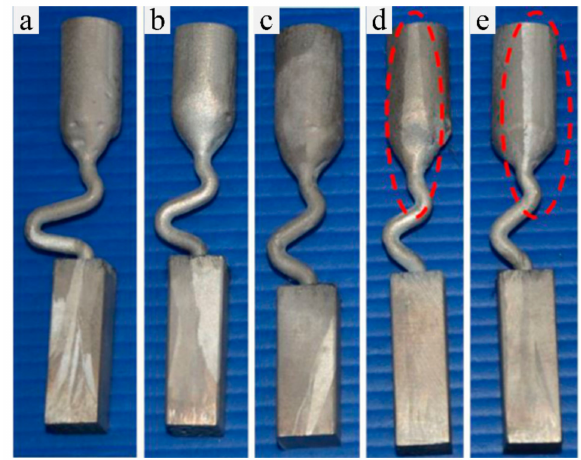
Figure 2. Z-form 2D grain selector with di ff erent take-o ff angle: ( a ) θ = 15 ◦ , ( b ) θ = 30 ◦ , ( c ) θ = 40 ◦ , ( d ) θ = 50 ◦ , ( e ) θ = 60 ◦